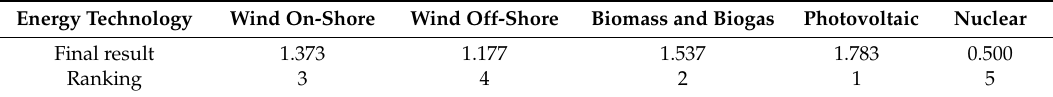
Table 11. Ranking of low-emission energy technologies with weights provided by